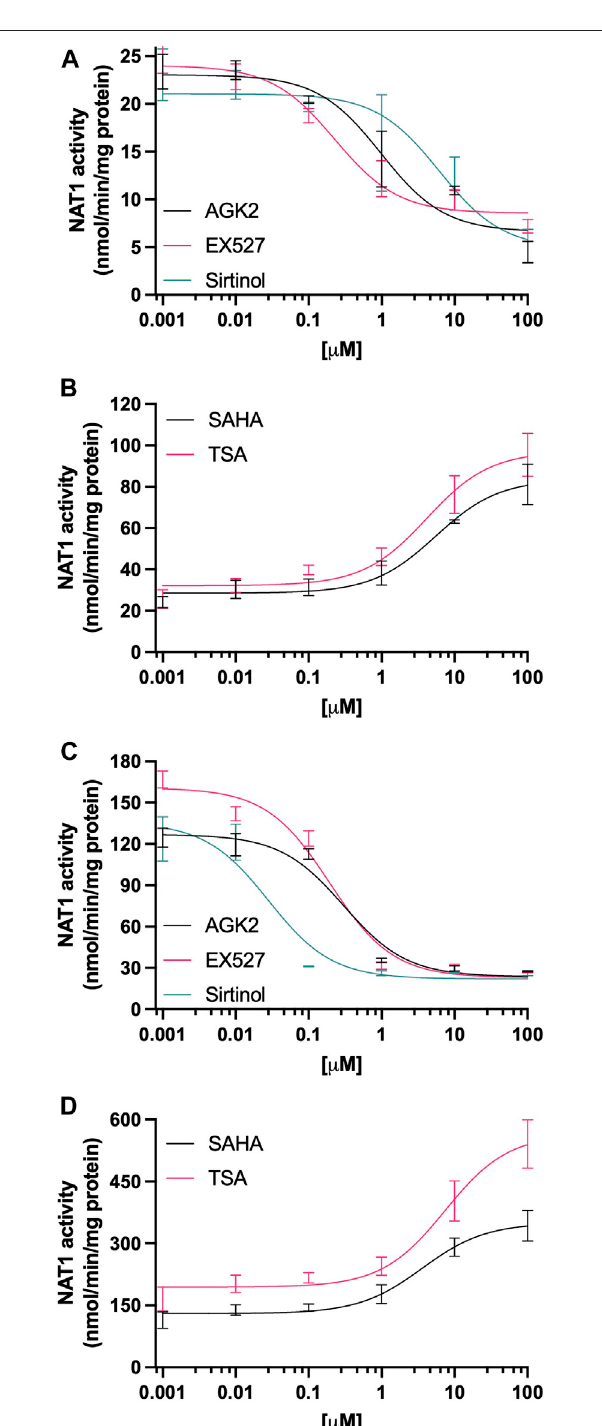
FIGURE3| EffectofKDACinhibitiononthecatalyticactivityofNAT1. (A) MDA-MB-231 cells or (C) ZR-75-1 cells were treated with AGK2 (black line), EX527 (pink line) or Sirtinol (green line), then PABA N -acetylation activity was quanti fi ed. (B) MDA-MB-231 or (D) ZR-75-1 cells were treated with SAHA (black line) or TSA (pink line), then PABA N- acetylation activity was quanti fi ed. Data is presented as the mean ± SEM of four independent